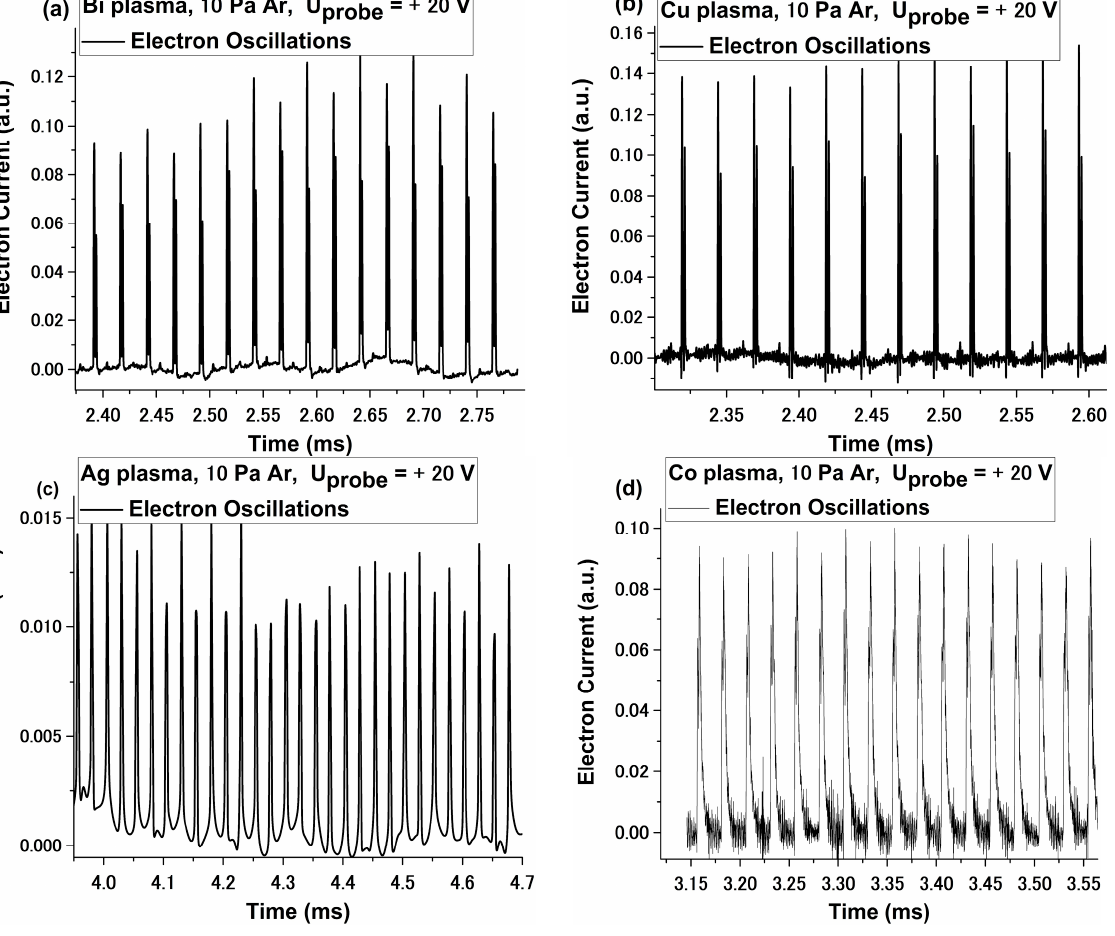
Figure 3. Example of oscillatory regime for Bi ( a ), Cu ( b ), Ag, ( c ) and Co ( d ) plasmas at (+20V) at 10 Pa of Ar.